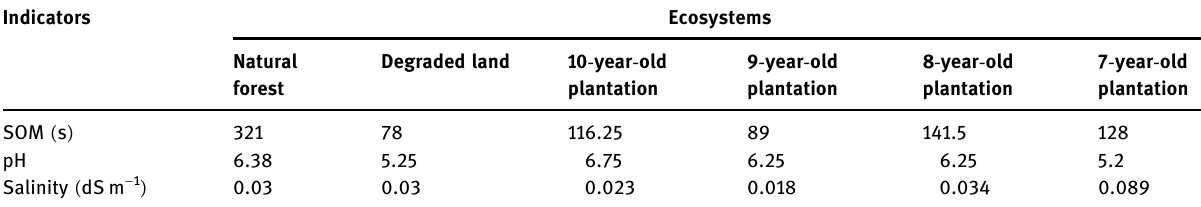
Table 3: Chemical indicators and criteria of soil health evaluation in natural forest, agricultural, and degraded ecosystems Indicators